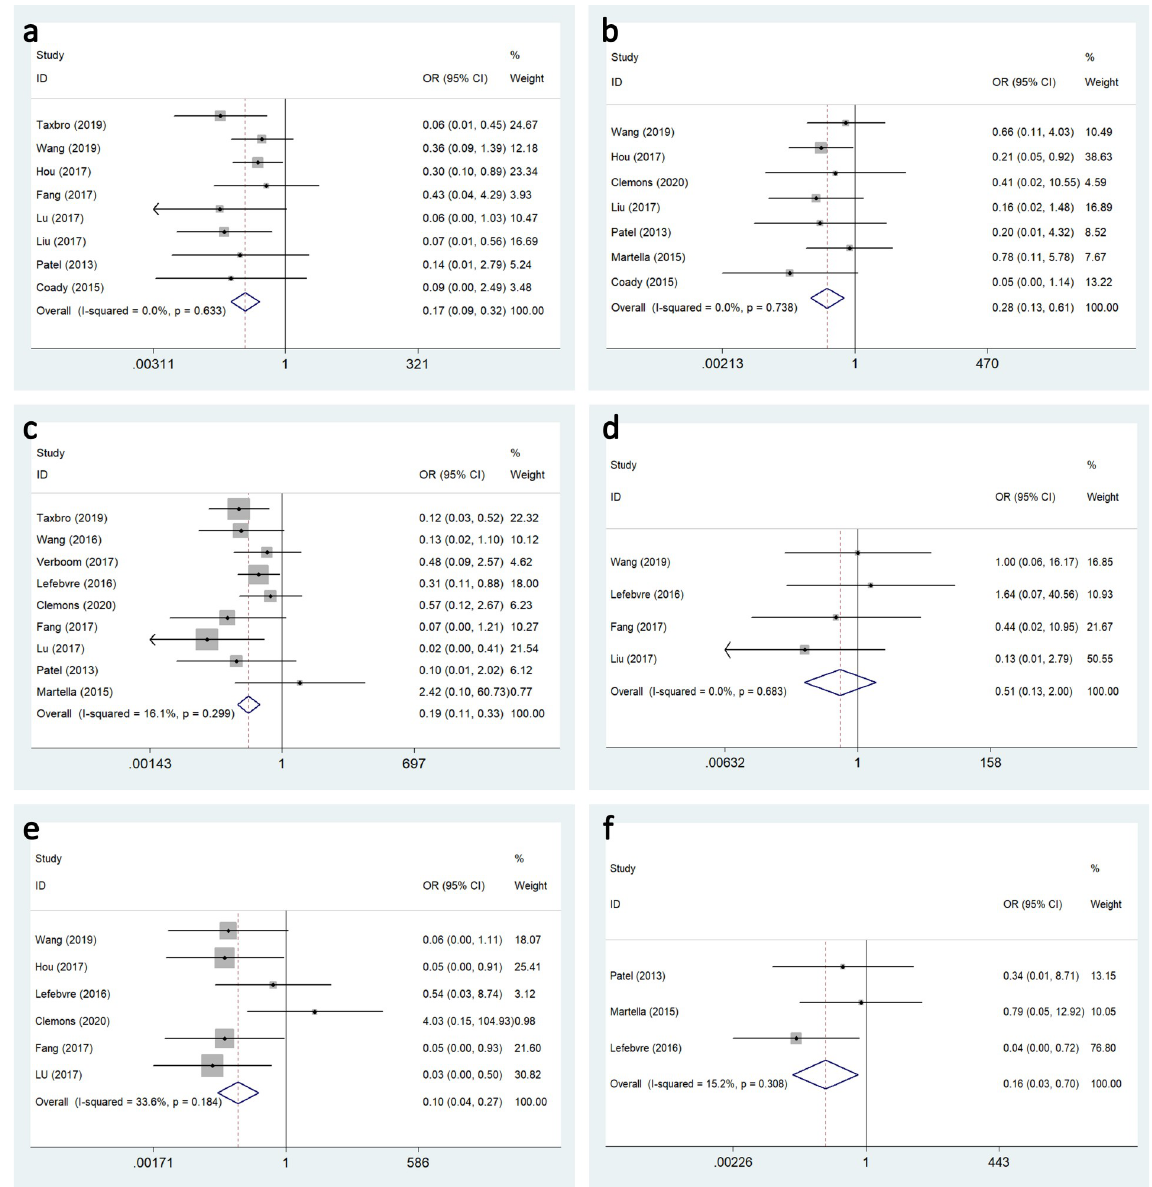
Fig 4. Forest plot for the relationship of TIVAP and PICC with the risk of follow complications. (a)occlusion, (b) malposition, (c) catheter- related thrombosis, (d) extravasation, (e)phlebitis, (f) allergy.